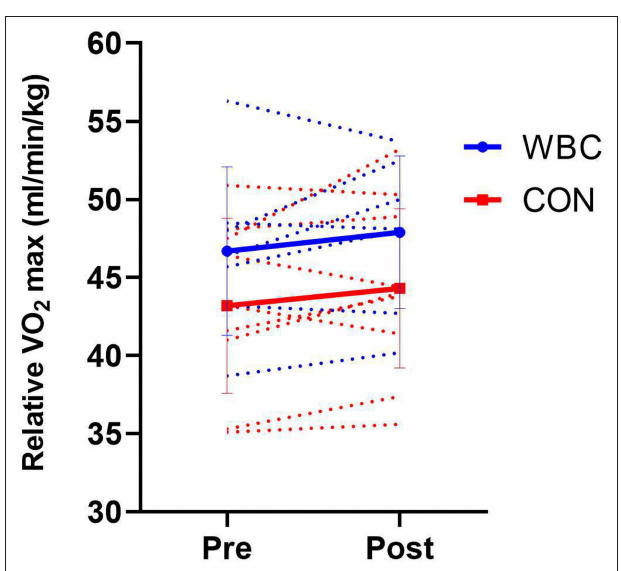
FIGURE 3 | Relative VO 2 max for WBC ( n = 7) and CON ( n = 9) groups before and after 6 week training programme. Solid lines present means ± standard deviations. Dotted lines present individual participant responses. N =